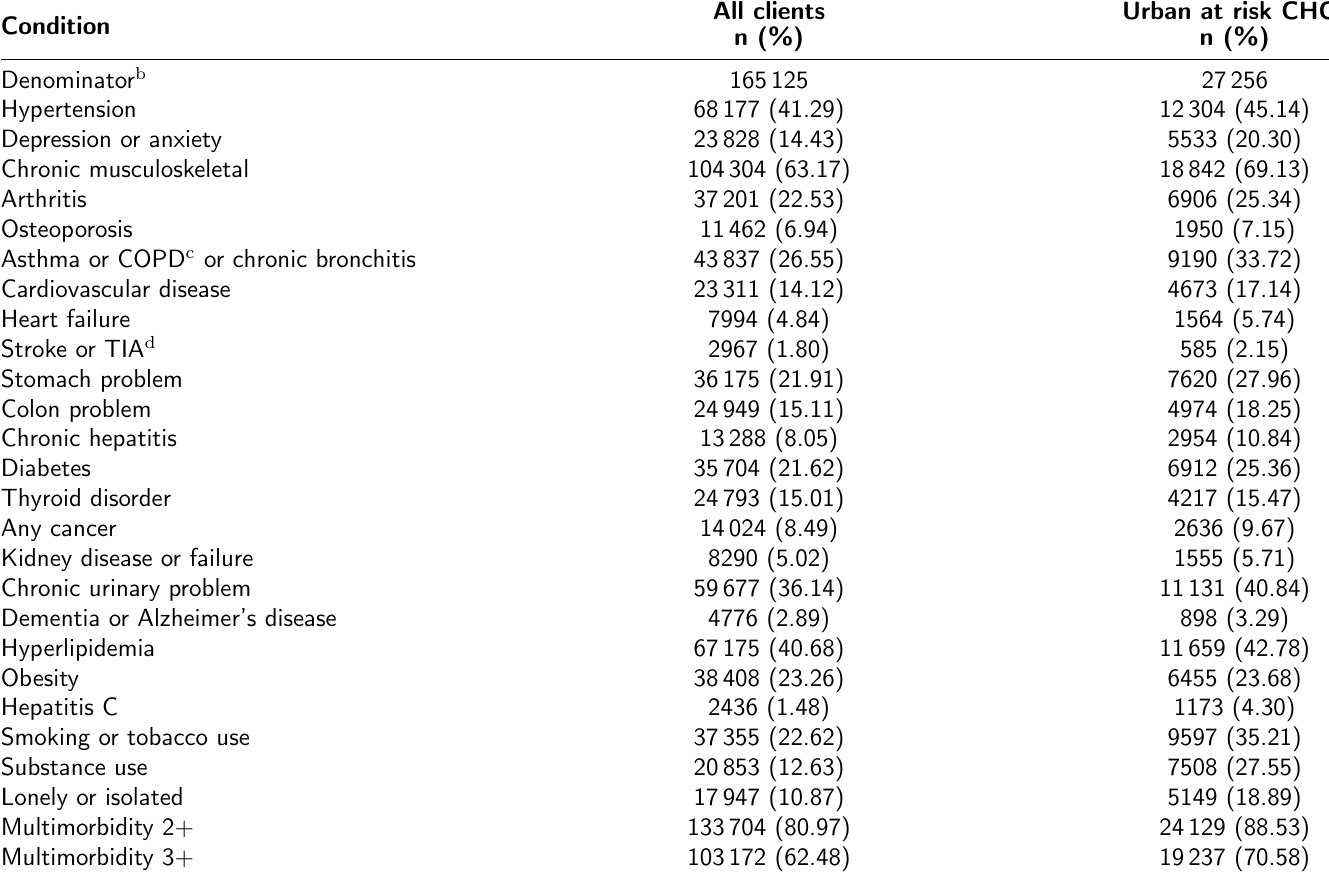
Table 2: Eleven-year period